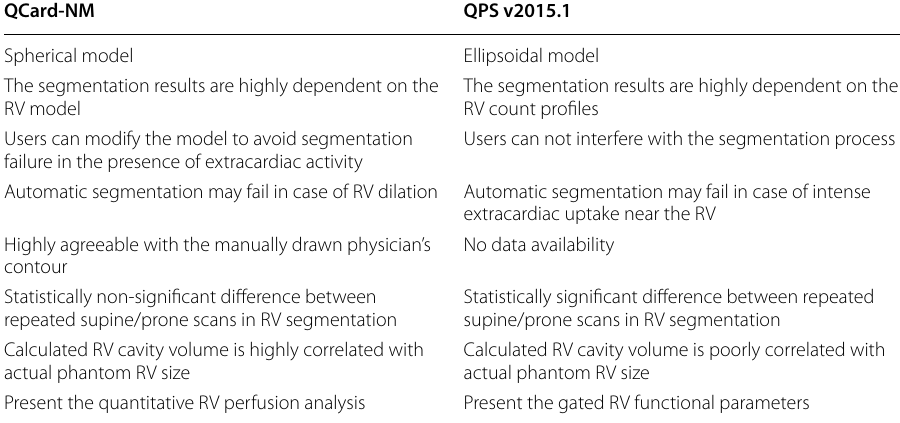
Table 6 Comparison of the QCard-NM and QPS packages in RV segmentation QCard-NM QPS